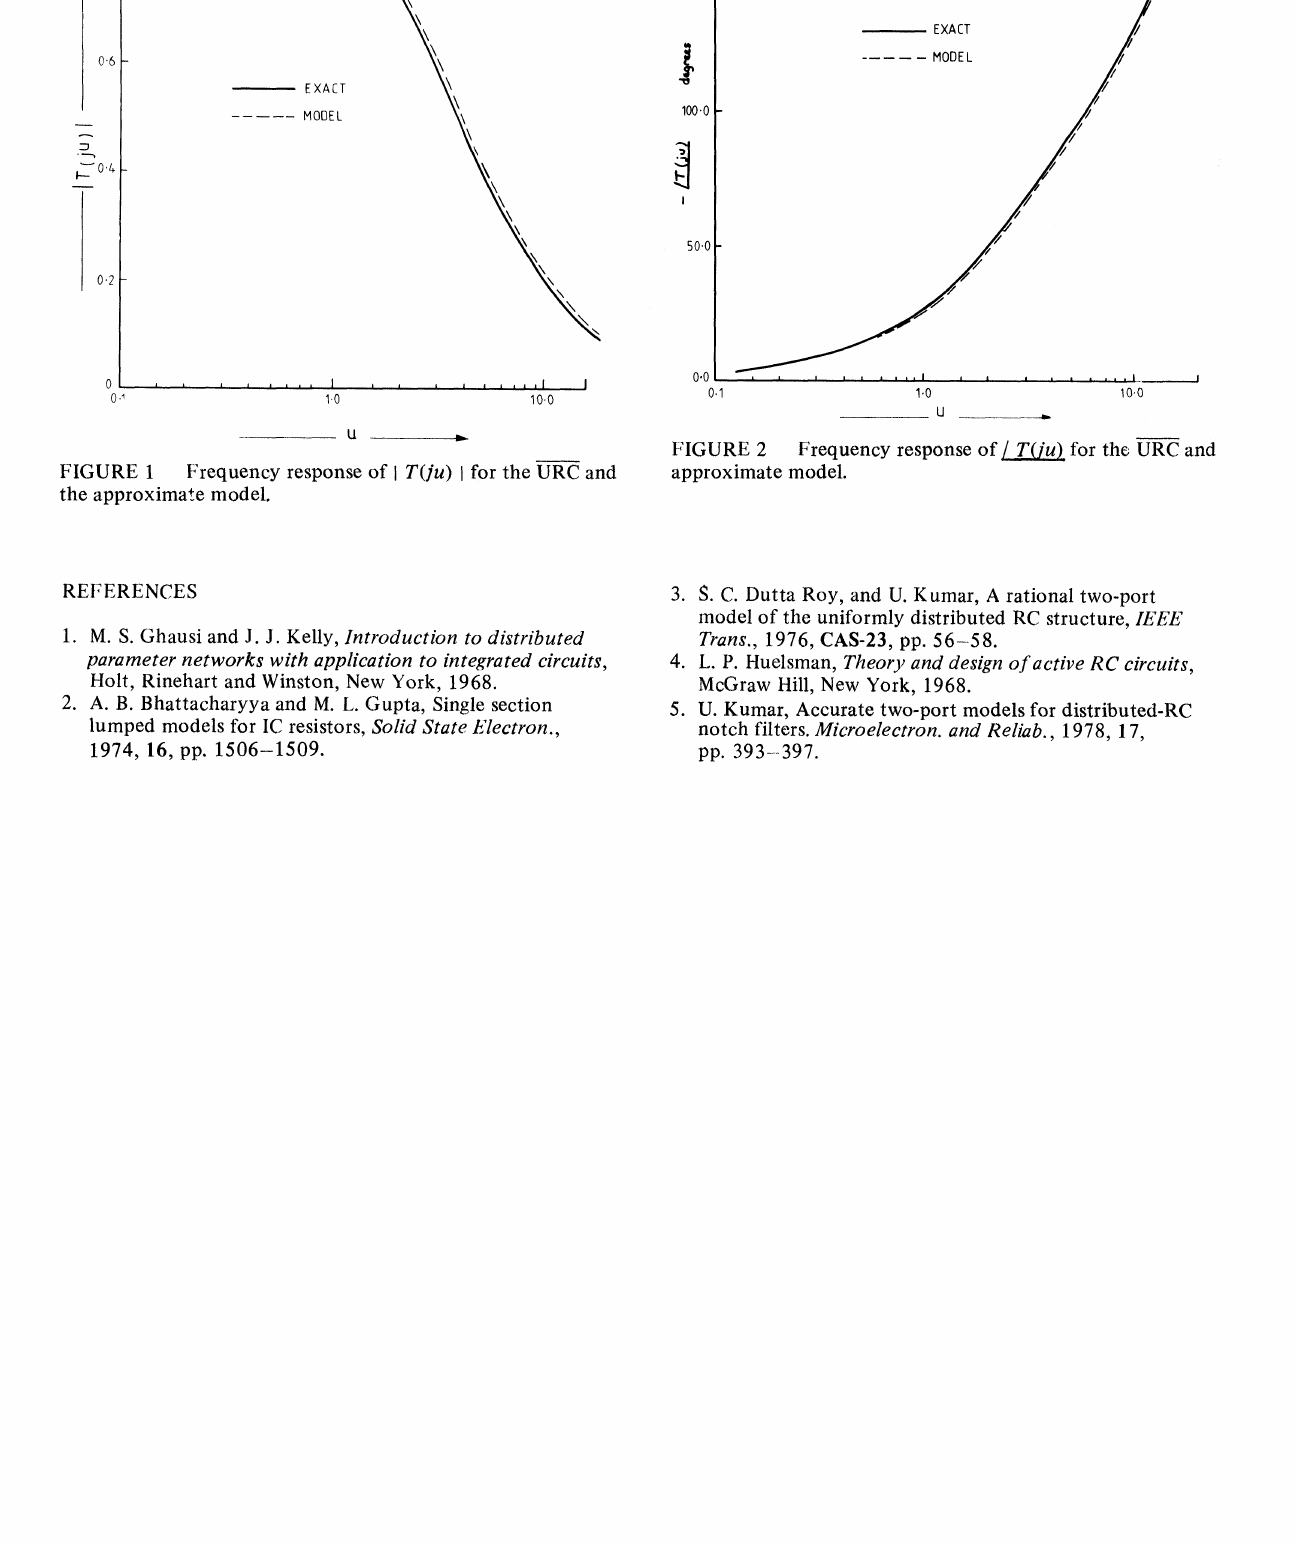
FIGURE 2 Frequency response of /(/’u)j for the URC and approximate